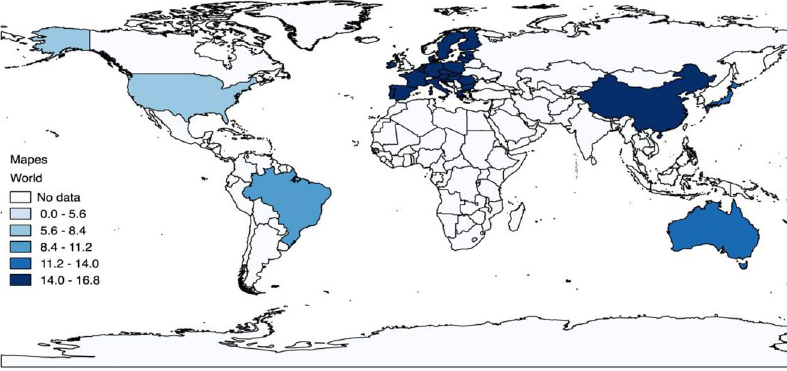
Fig. 5 Employment attributed to foreign final consumption in relation to total employment (%), 2014. Source: Author’s calculations based on the